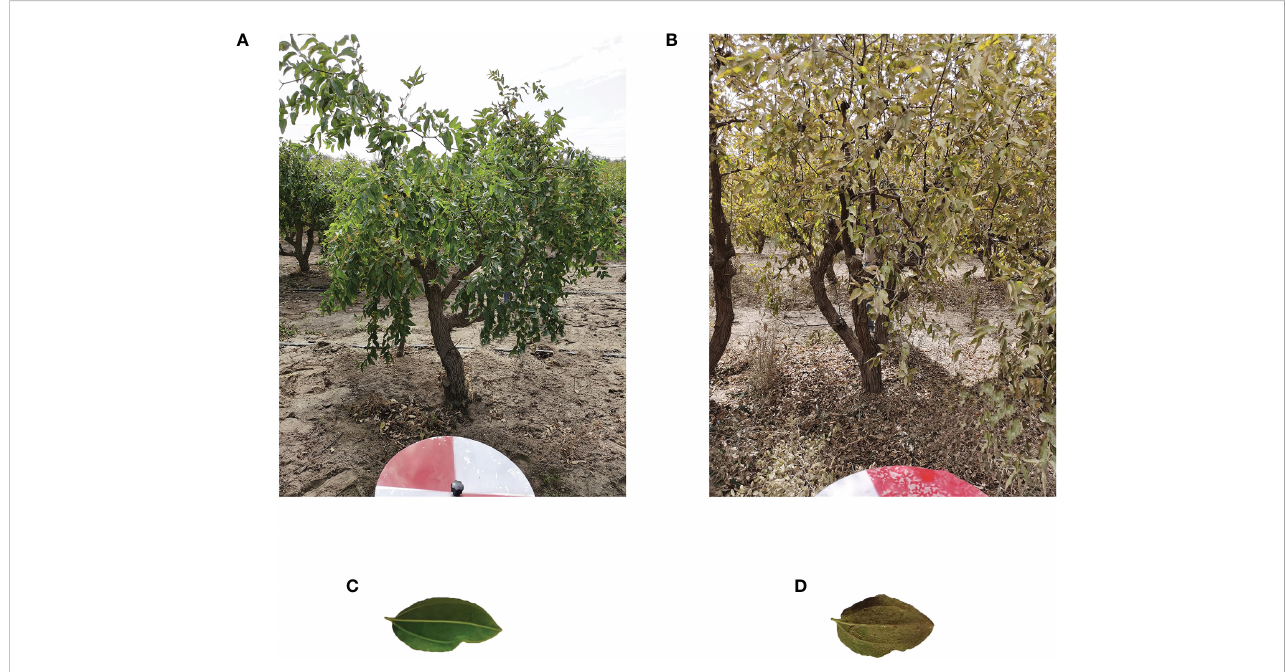
FIGURE 6 Images of healthy jujube trees and infected jujube trees. (A) Healthy jujube tree, (B) Infected jujube tree, (C) Leaf of healthy jujube trees, (D) Leaf of infected jujube